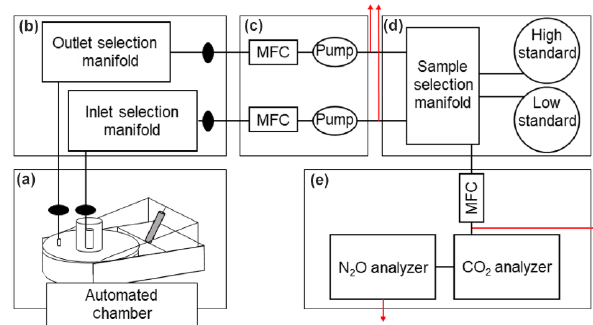
Figure 5. Schematic of the sample selection system. Mass flow con- trollers are abbreviated MFC. Filters are denoted by black ovals. Red arrows indicate where needle valves vent excess flow. Figure panel labels are defined in the main